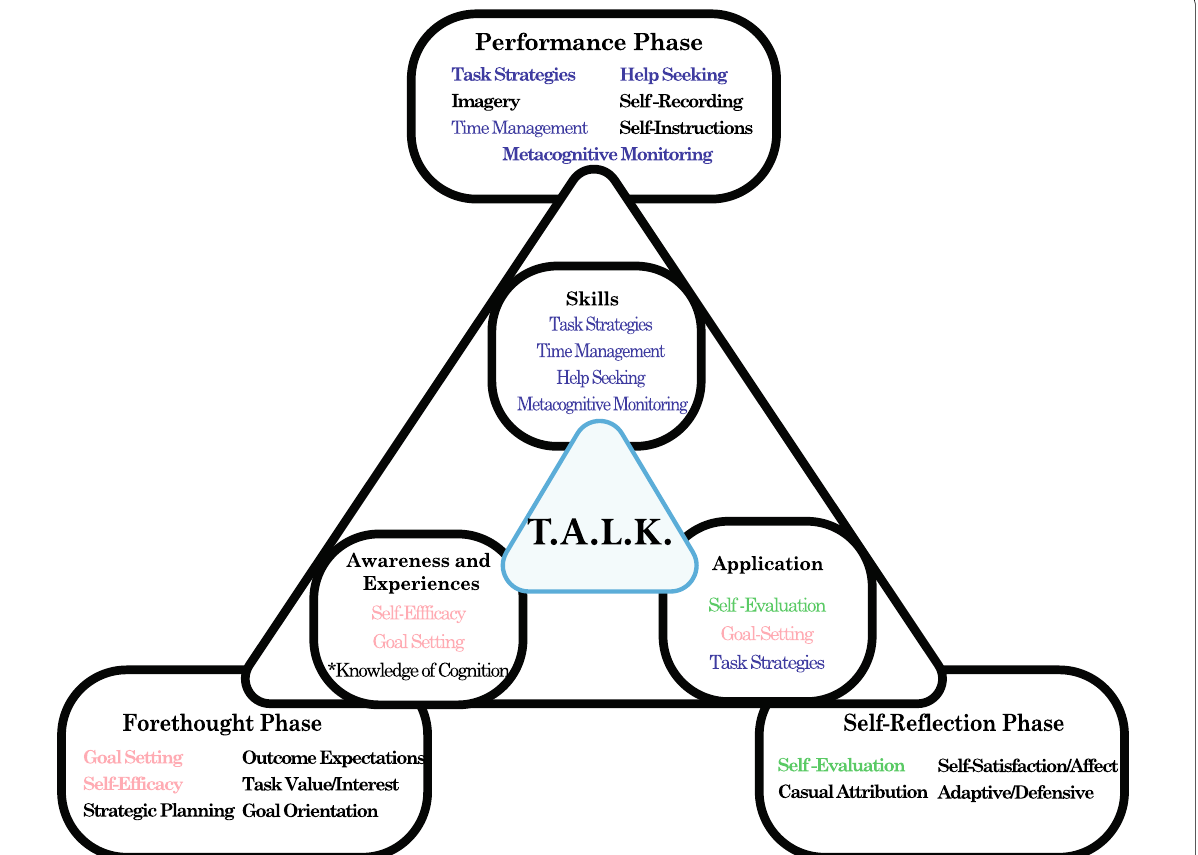
Fig. 2 Metacognitive framework. The outer triangle represents the iterative process as described by Zimmerman. The framework described in this study utilizes a selected subset (inner triangle) of these attributes consistent with Flavell’s four components of metacognition. Attributes in pink, blue and green were selected from the forethought, performance, and self-reflection phase, respectively. Two of Flavell’s constructs “metacognitive experiences” and “metacognitive knowledge” are taken together as “Awareness and